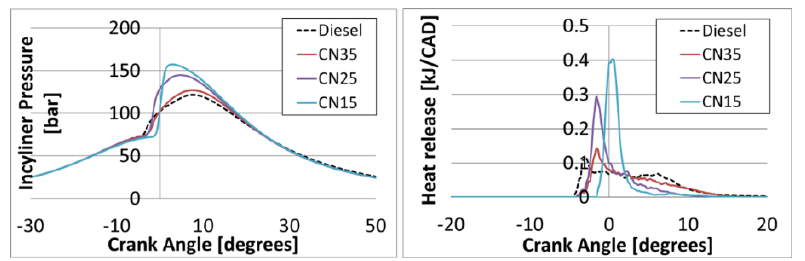
Figure 2. Average (250 cycles) in-cylinder pressure and heat release curves using different CN fuels in a 1.6 L CI engine at 10 bar of BMEP and 2650 rpm (with single injection).